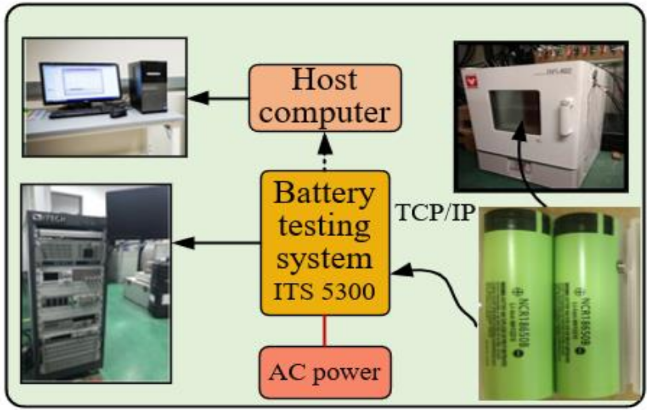
Figure 6. The testing platform for experiments.